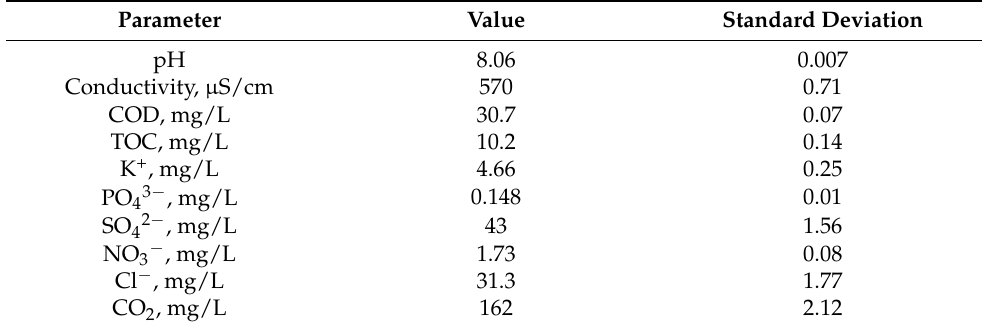
Table 1. Characteristic parameters of natural river water